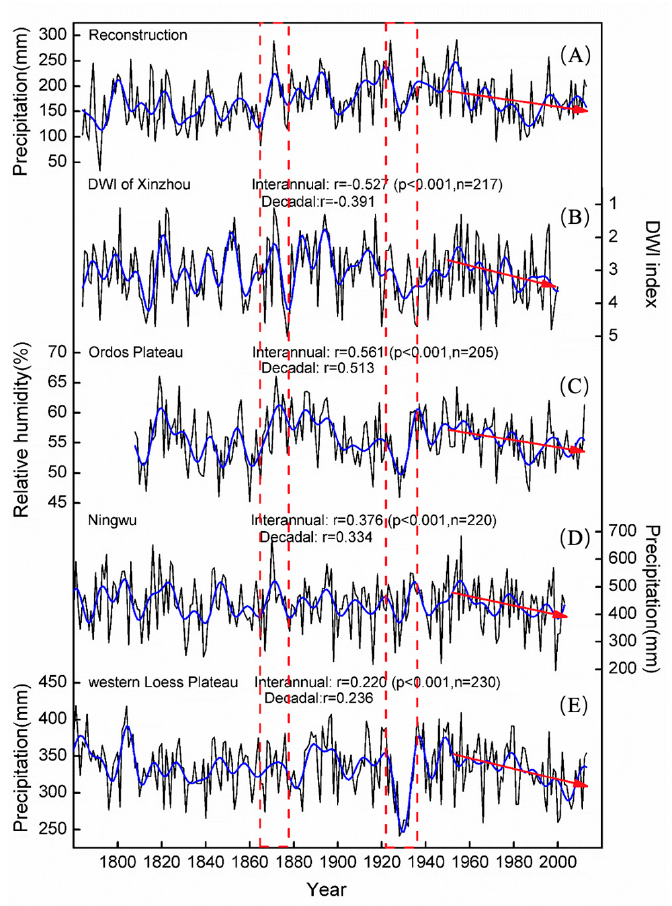
Figure 8. Comparison between the reconstruction in this study and other records. ( A ) The recon- structed precipitation variations in this paper, ( B ) the DWI in Xinzhou [26], ( C ) the June–August relative humidity in Ordos Plateau [6], ( D ) the annual precipitation from previous-year August to current-year July in Ningwu [15], and ( E ) the annual precipitation from previous July to current June in western Loess Plateau [11]. Black lines: original data; blue lines: 10-yr low-passed filtered; dotted boxes: common wet or dry period; red arrows: drought trend.